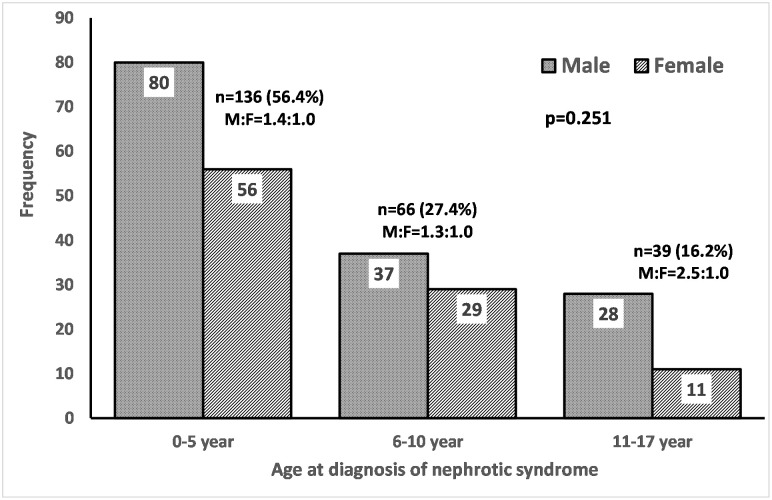
Age and sex distribution of idiopathic nephrotic syndrome in children.